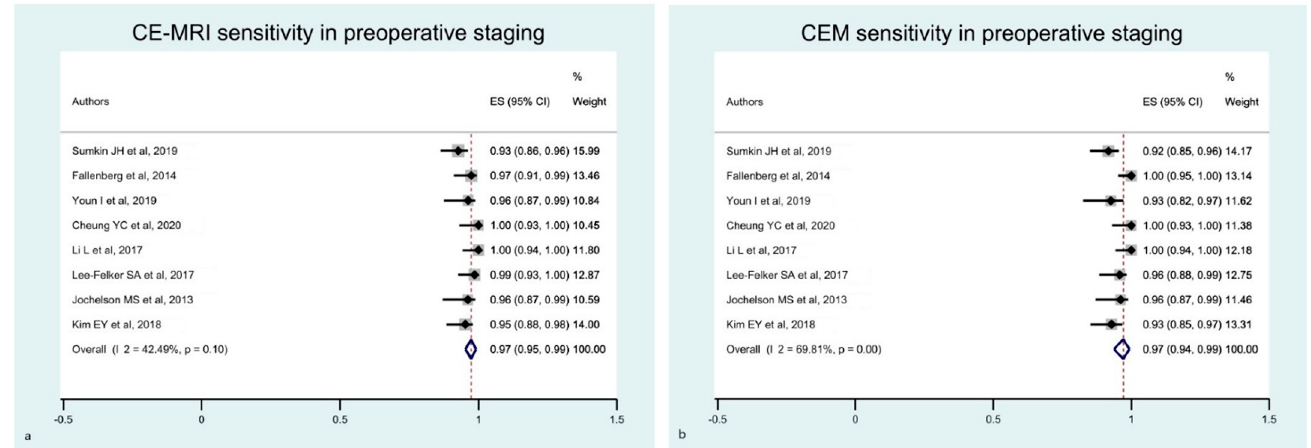
Figure 7. Forest plot of the estimated pooled sensitivity of breast CE-MRI ( a ) and CME ( b ) in preoperative staging. The estimated pooled sensitivity of CE-MRI ( a ) was 0.97 (95% CI 0.95 – 0.99), with a moderate heterogeneity (I 2 = 42.49% p = 0.01). The estimated pooled sensitivity of CME ( b ) was 0.97 (95% CI 0.94 – 0.99), with a moderate heterogeneity (I 2 = 69.81% p = 0.10) [19,22,23,24,25,26,33,34] .